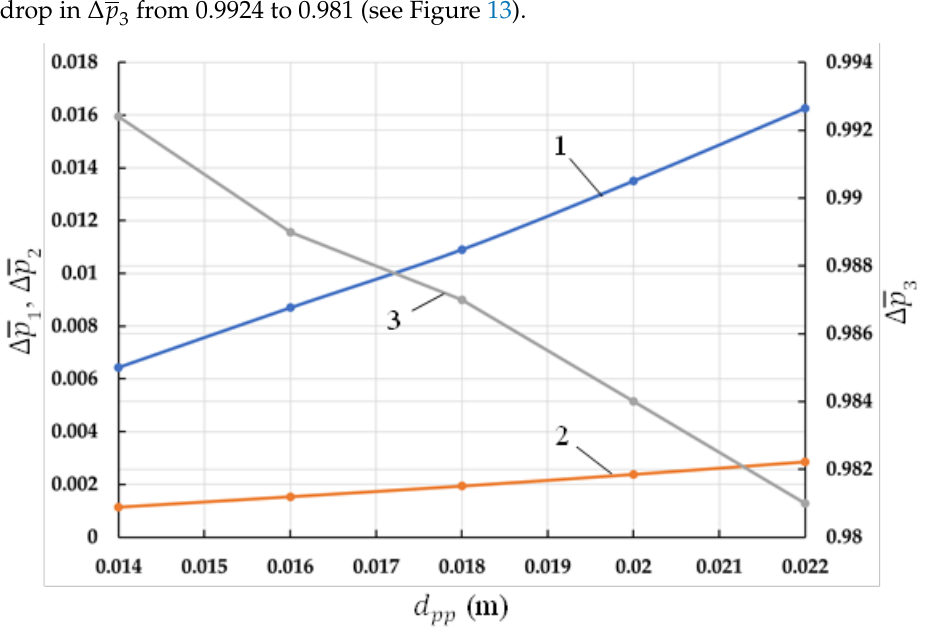
; ∆ p ; ∆ p , on the diameter of the supply pipeline ; 𝛥𝑝 ; 𝛥𝑝 , on the diameter of the supply pipe- 1 2 3 1 2 3